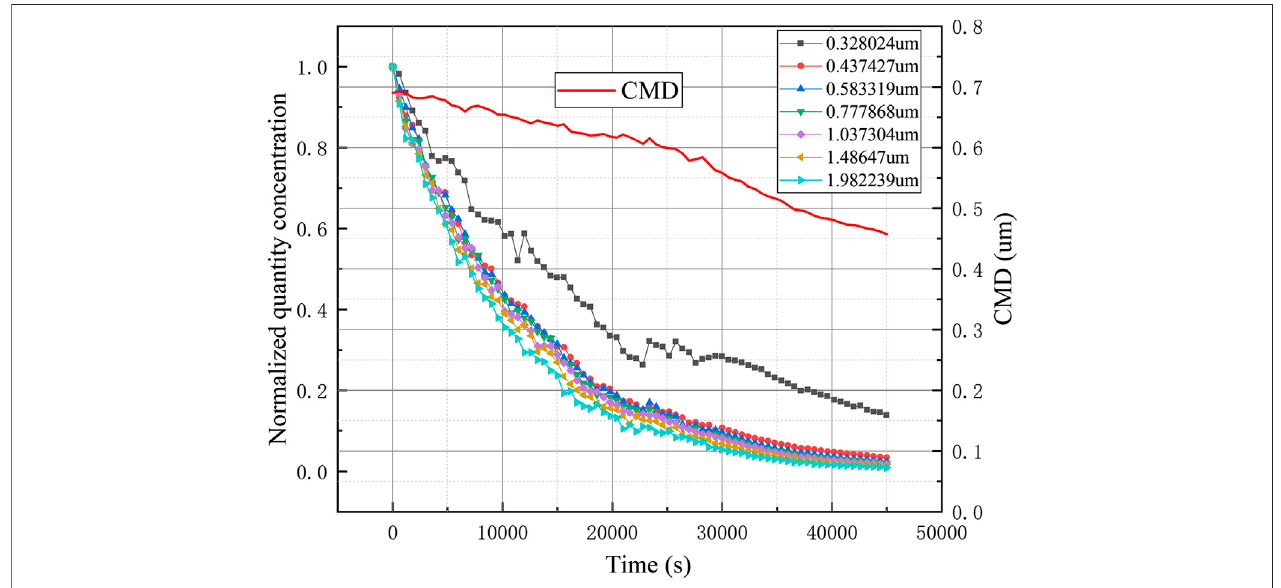
FIGURE 12 | Erosol concentration and particle CMD with time.